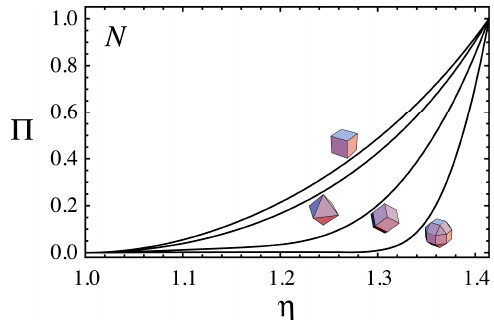
Figure 4. The relationship between Π given by Equation (9) and η for the hexahedral, octahedral and dodecahedral and RCO superspheres, where Π is a function of N .